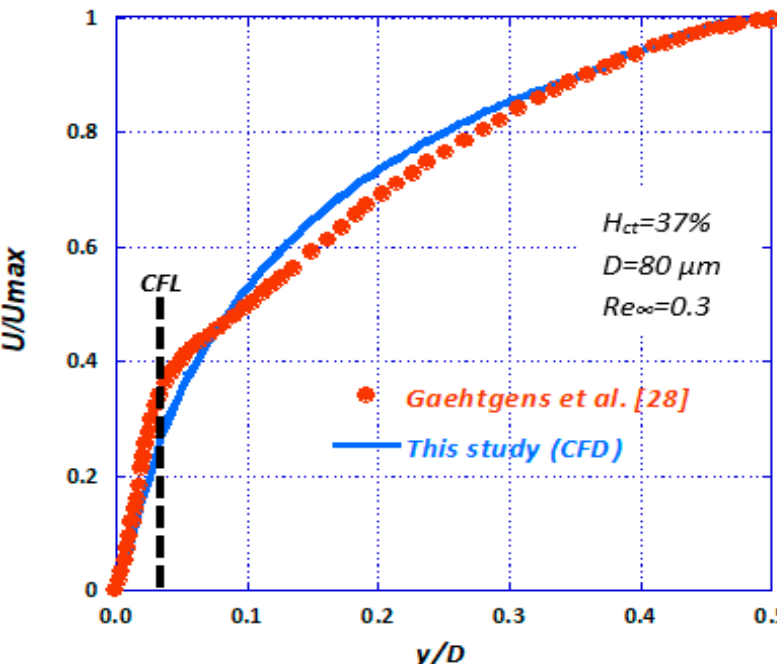
Figure 16. Comparison of numerically calculated axial velocity with published experimental data [28] ( D = 80 μ m, Re ∞ = 0.3, H ct = 37%).